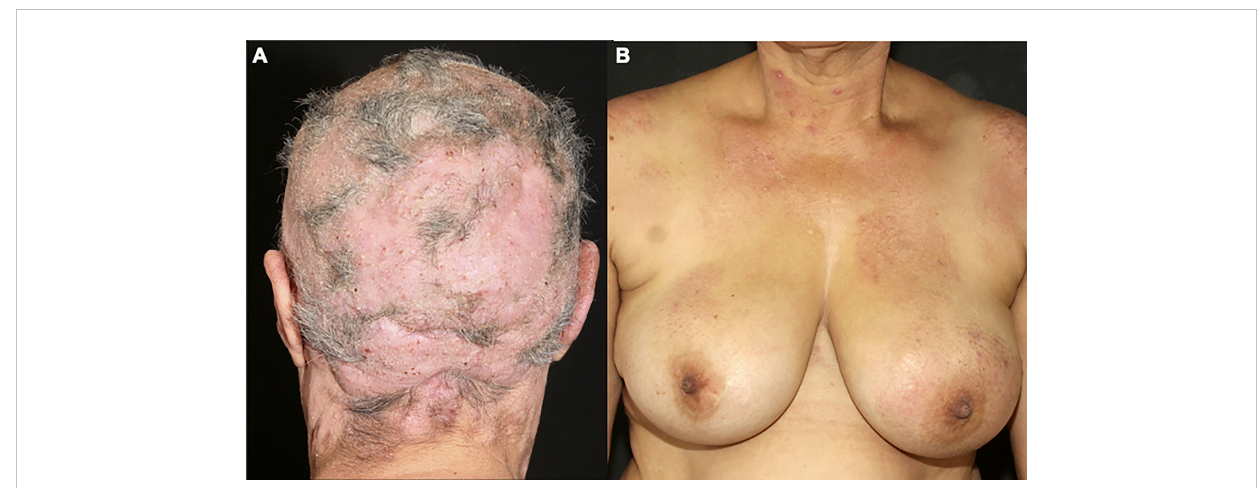
FIGURE 2 Folliculotropic MF. Advanced folliculotropic MF with in fi ltrated plaques on the scalp causing alopecia and milia (A) ; early folliculotropic MF with patches and plaques with comedones and milia on the breasts, thorax, and neck (B)